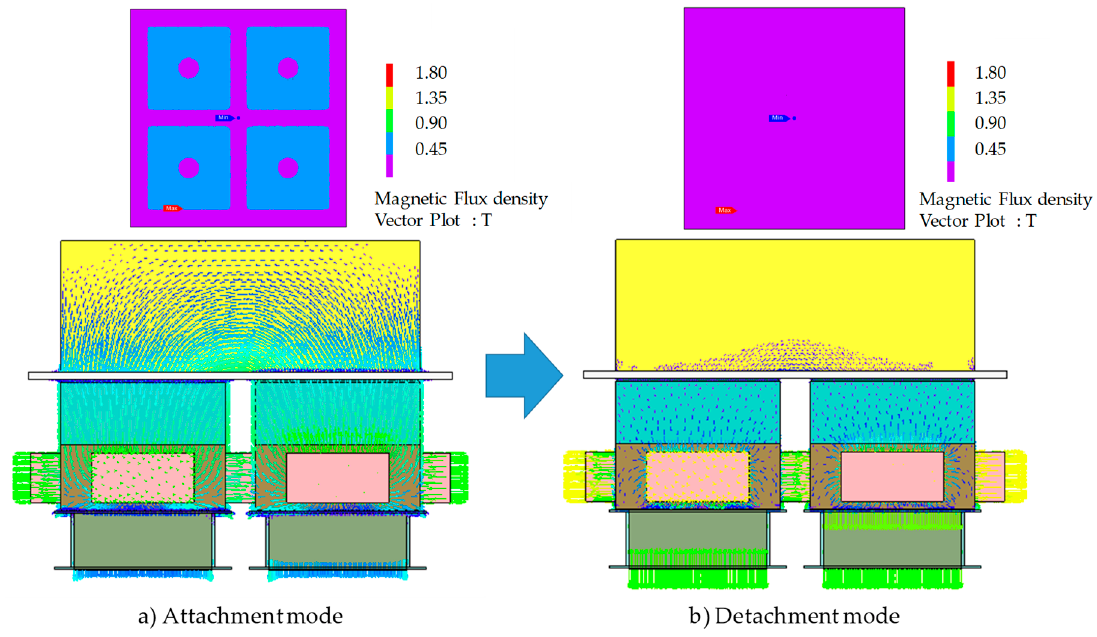
Figure 12. Magnetic flux density of H-EMMs in ( a ) attachment mode; ( b ) detachment mode.